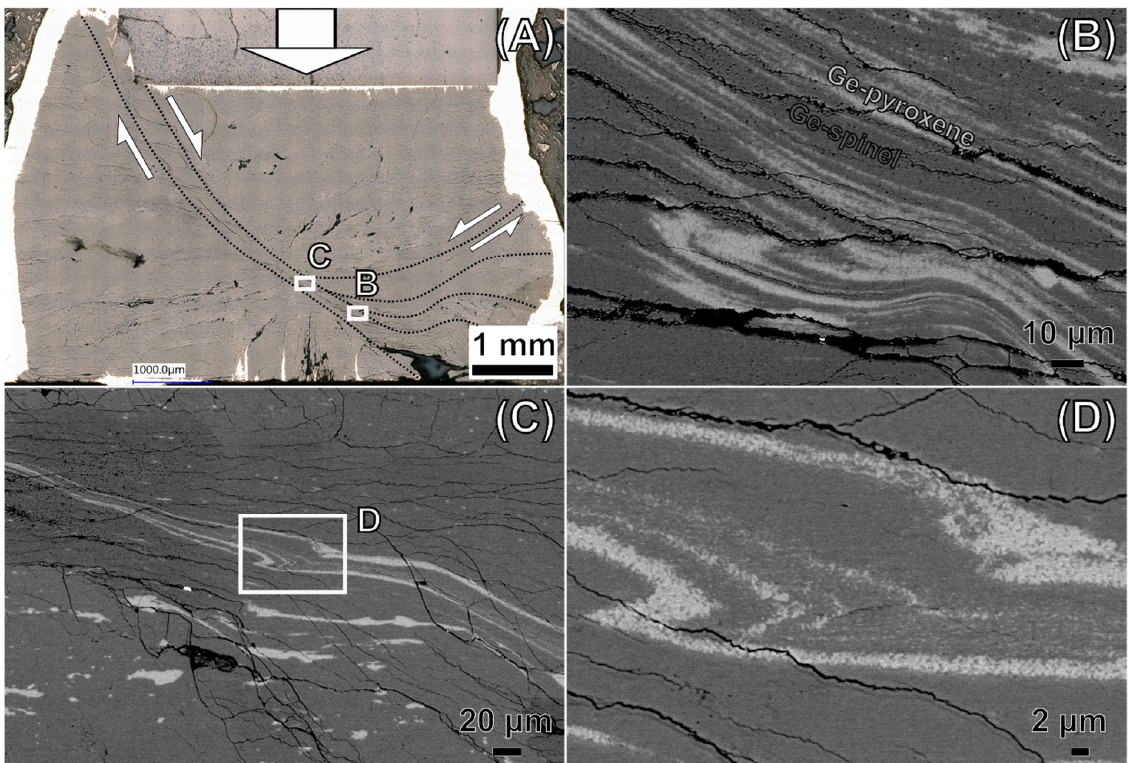
Figure 7 . Microscopy images of sample G15 (843 °C). Compression direction is vertical on all images. ( A ) Optical image showing the entire sample. The alumina piston used for axial shortening is visible at the top of the image. The down pointing arrow indicates the motion of the piston during deformation. ( B , C ) SEM images of in backscatter electron mode of the principal shear zone according to the white squares in ( A ). Black wavy cracks correspond to brittle damage caused by decompression, which locates preferentially in the deformed regions. ( B ) Ge-pyroxene, which appears brighter, is present in the form of recrystallized fine-grained layers that evidence the shearing direction. ( C ) The initial undeformed texture is mostly preserved in the bottom of this image and contrasts with the dramatic pyroxene stretching in the shear band in the center of the image. ( D ) Close-up view according to the rectangle in ( C ). At this scale, sub-micron Ge-pyroxene grains are visible and evidence that grain elongation occurs via substantial dynamic recrystallization.